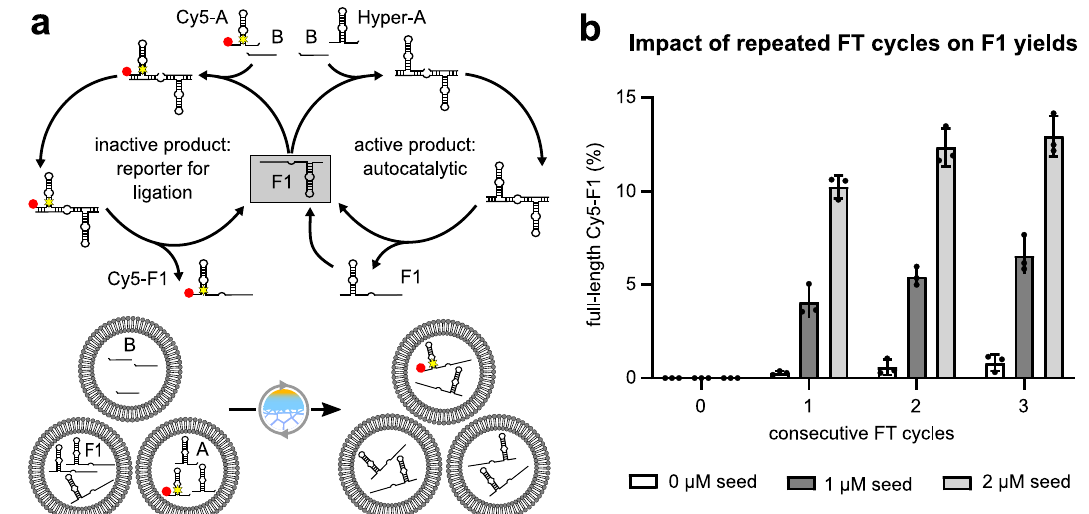
Fig. 2 | Autocatalytic self-replication of GUV-encapsulated F1 ligase after FT- induced content mixing. a The reaction cycle of the autocatalytic ligase system starting from an initial seed of unlabelled ribozyme (F1) (top panel) and the three distinct vesicle populations used for freeze-thaw (FT)-driven self-replication of RNAs(bottompanel).Additionofthe fl uorescentlylabelledsubstrateCy5-Ayieldsa catalytically inactive reporter product (Cy5-F1) that allows the monitoring of the reaction progress using fl uorescent PAGE analysis. To make F1 self-replication dependent on GUV content exchange, separate GUV populations encapsulating either the F1 seed, substrate A or substrate B were mixed in a 1:1:1 ratio before FT